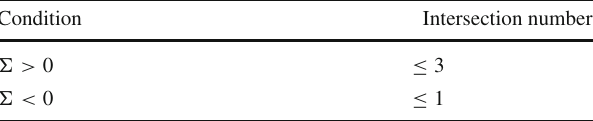
Table 4 Constraints on the intersection number for φ 0 ,φ ± when h ∈ C , Re ( h ) = 0, σ,λ ∈ C , Re (λ) ≥ 0, and d (cid:10)= 0 Condition Intersection number